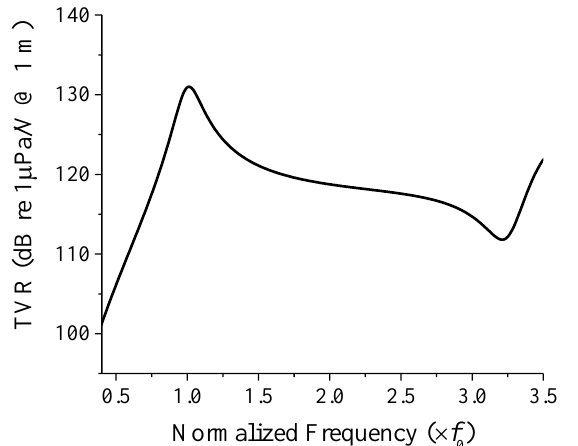
Figure 11. TVR spectrum of the immersed cymbal transducer calculated with the equivalent circuit in Figure 2.